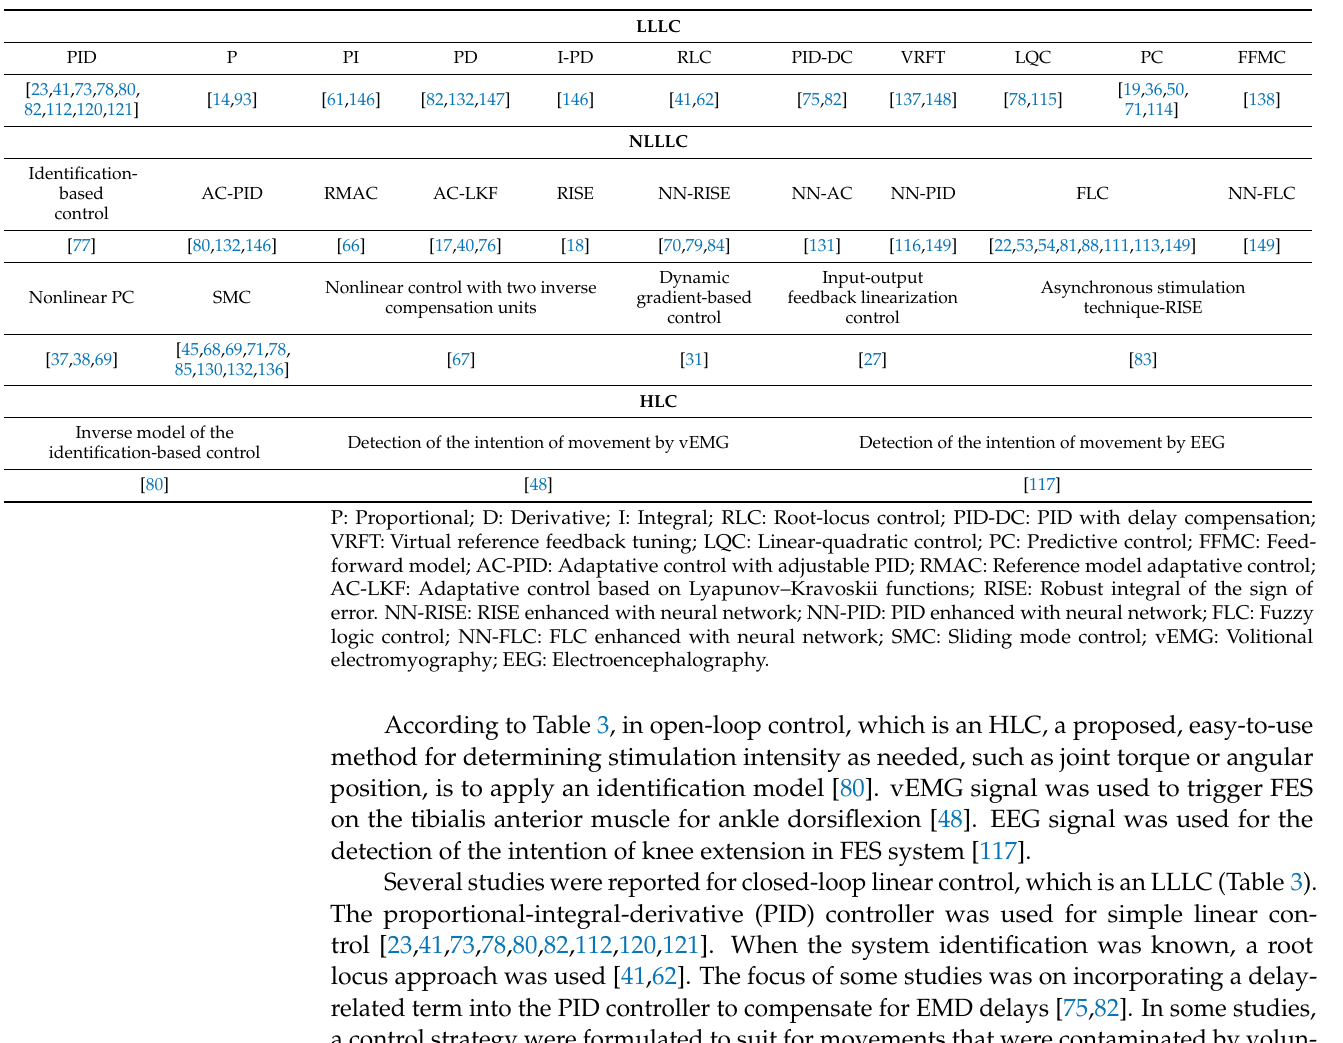
Table 3. Control strategies for simple flexion-extension movements of a